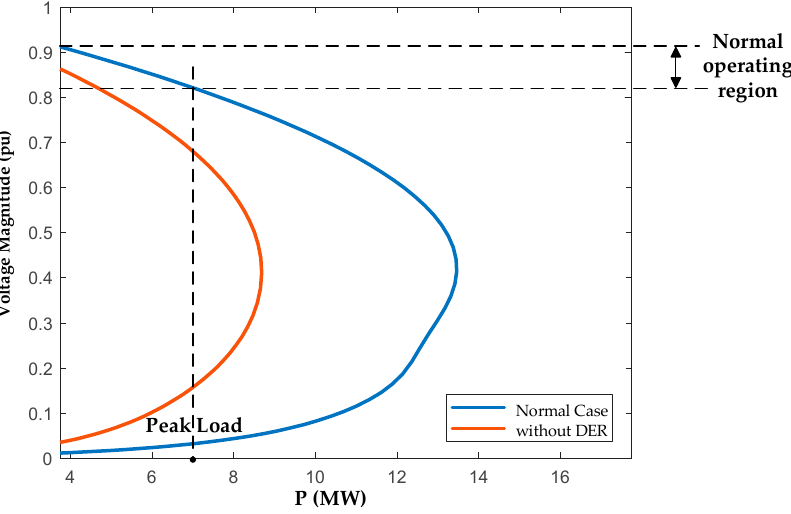
Figure 7. Comparison of the saddle-node bifurcation around the DER hosting capacity (5.28 MW).